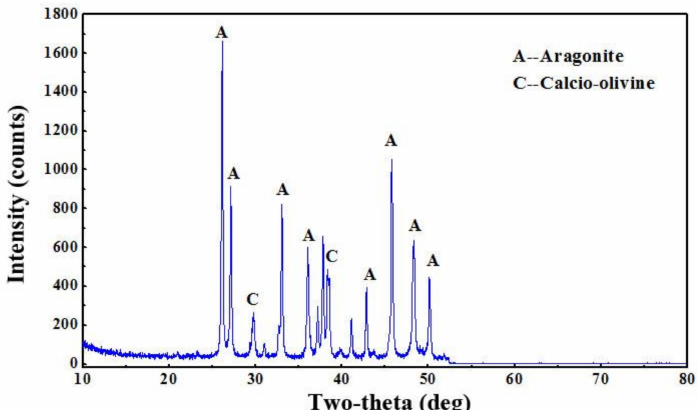
Figure 17. Mineral composition of the coral sand bulk.